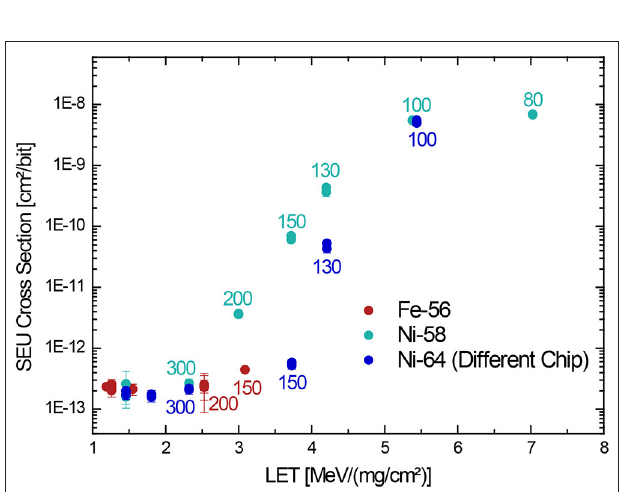
FIGURE 5 | Overview of results measured at GSI, TAMU, and RADEF [14]. The numbers at the data points are the ion energy in MeV/n.